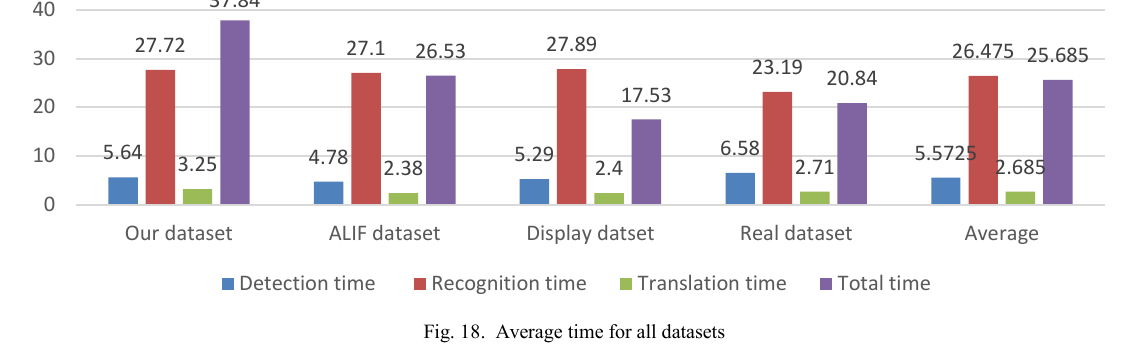
Fig. 18. Average time for all